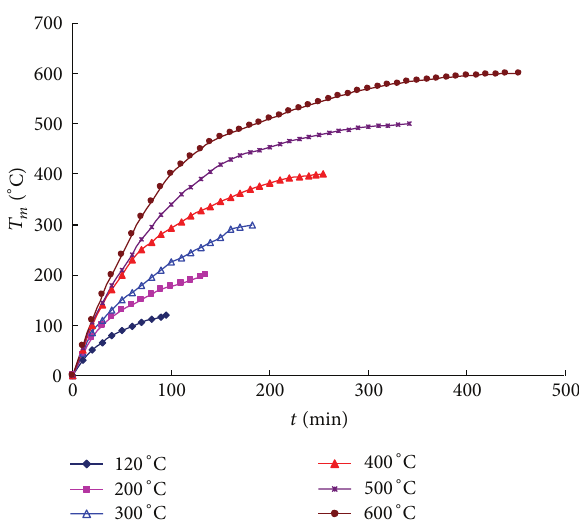
Figure 3: Typical temperature history of specimens.